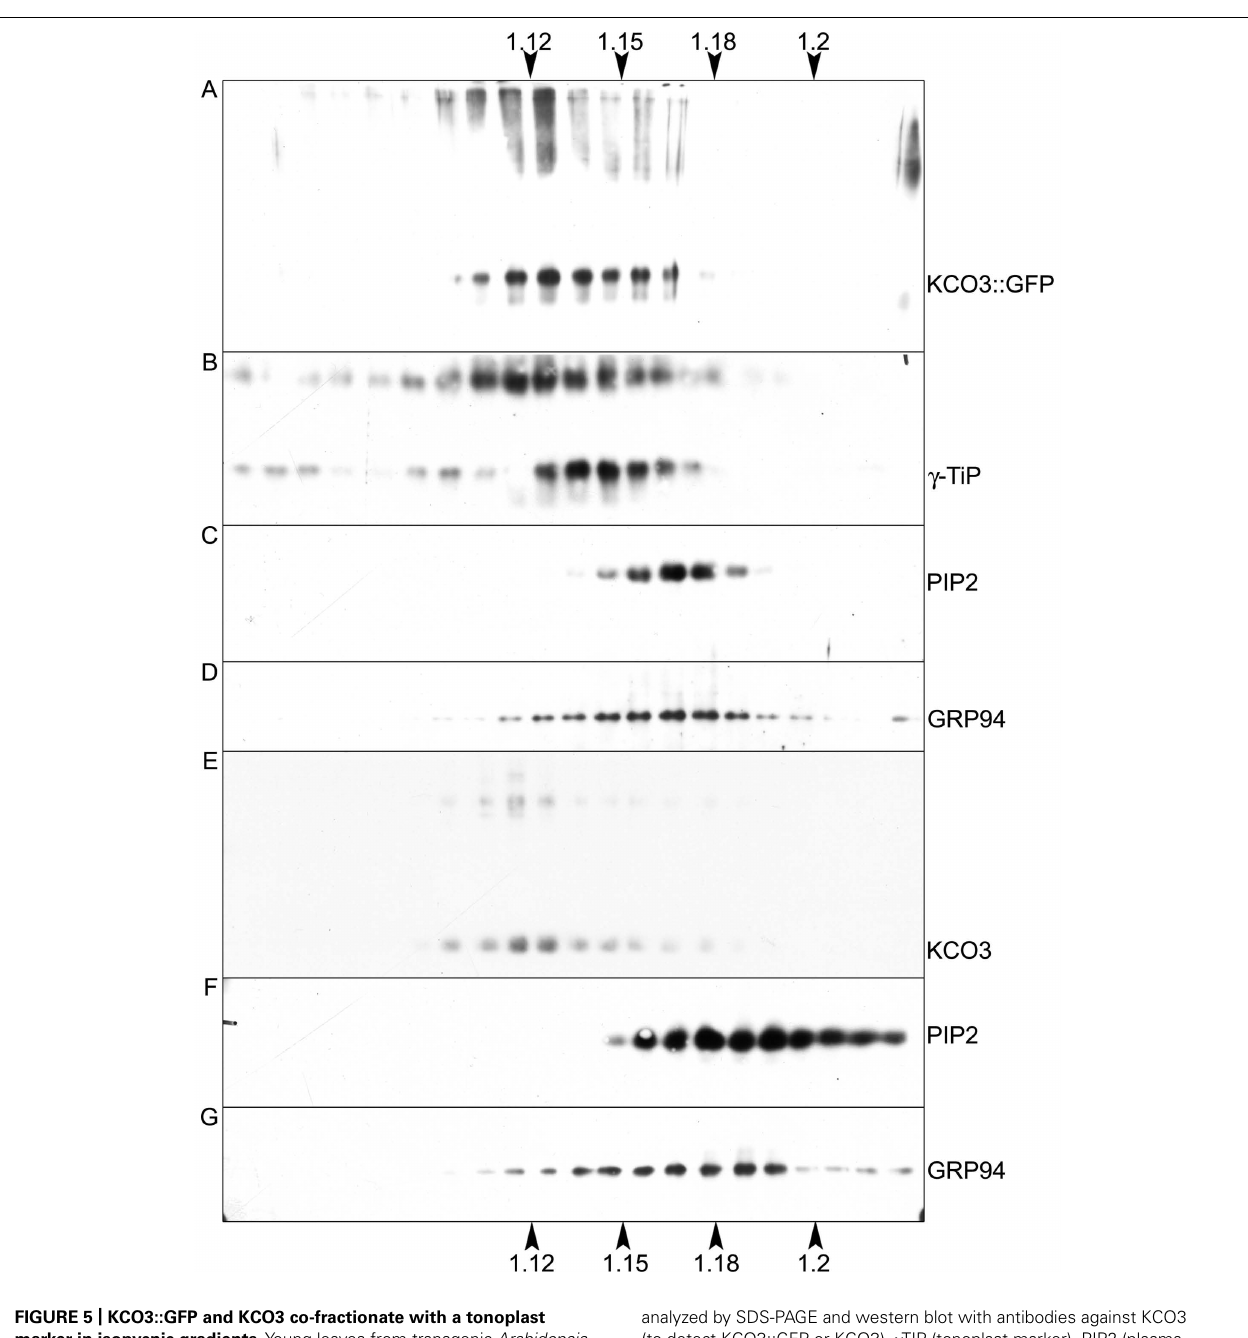
analyzed by SDS-PAGE and western blot with antibodies against KCO3 (to detect KCO3::GFP or KCO3), γ TIP (tonoplast marker), PIP2 (plasma membrane marker) or endoplasmin (GRP94, endoplasmic reticulum marker), as indicated at the right of each panel.Top of each gradient is at left; numbers on top or bottom of the figure indicate fraction density